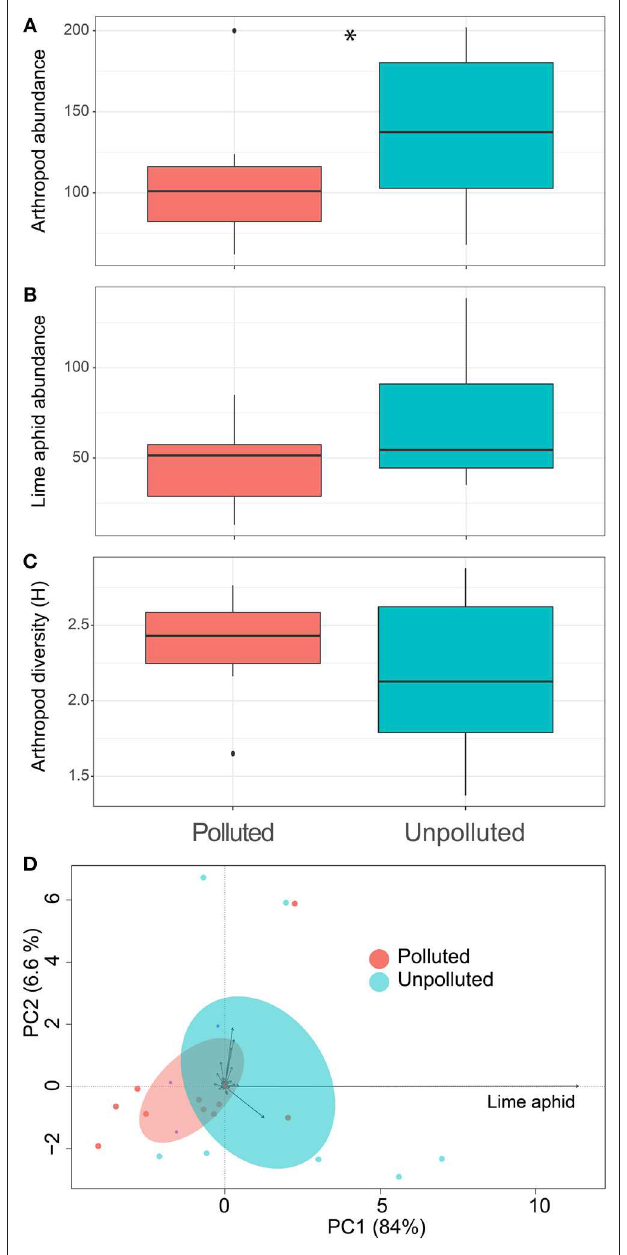
FIGURE 1 | Effect of salt pollution on lime trees associated arthropod diversity. Boxplots show the effect of soil pollution on (A) total arthropod abundance, (B) lime aphid abundance, and (C) arthropod Shannon diversity. Asterisks show significant differences among pollution sites (Chi-squared test, p < 0.05). Panel (D) shows the principal component arthropod’s ordination of the different sites. Blue is unpolluted soil, while red indicates highly polluted soils. Ellipses show 95% confidence intervals around the pollution groups.